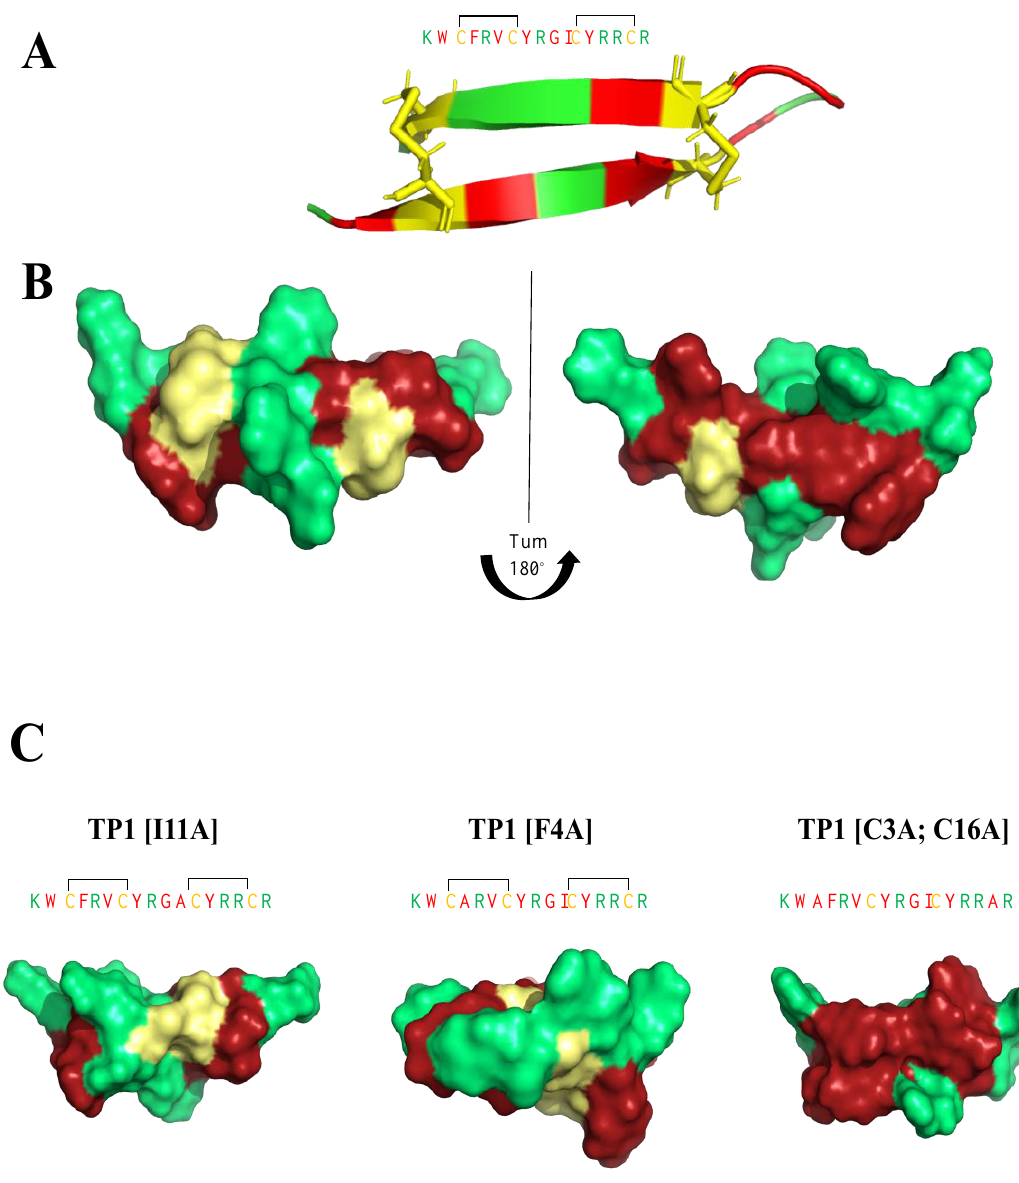
Figure 4. ( A , B ) Tachyplesin-1 (TP1) structure (PDB:1WO0). ( C ) I-Tasser calculations of TP1 analogues structure. Amino acids are colored in red (hydrophobic), green (positively charged) and yellow (cysteine).